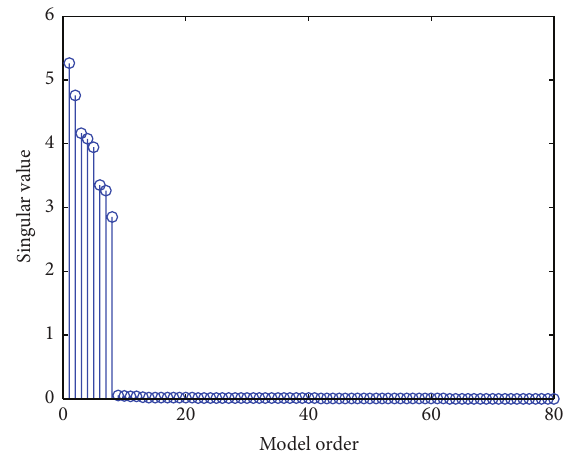
Figure 2: The frame structure: singular values of the output covariance matrix.